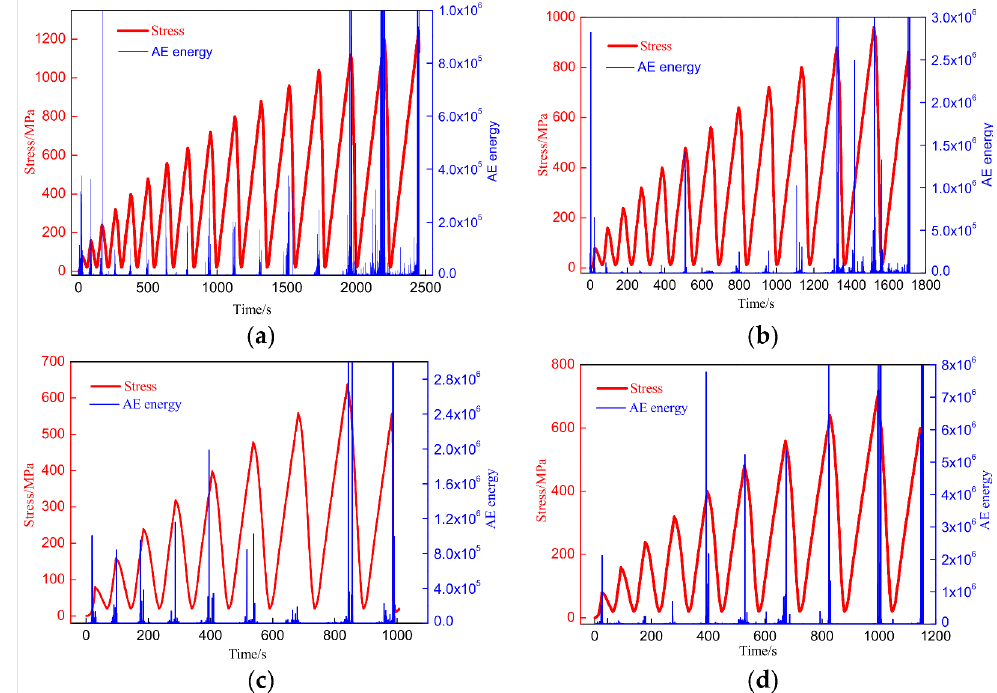
Figure 14. Stress and absolute energy evolution curves during cyclic loading and unloading of sandstone. ( a ) Sample A1; ( b ) sample A2; ( c ) sample A3; ( d ) sample